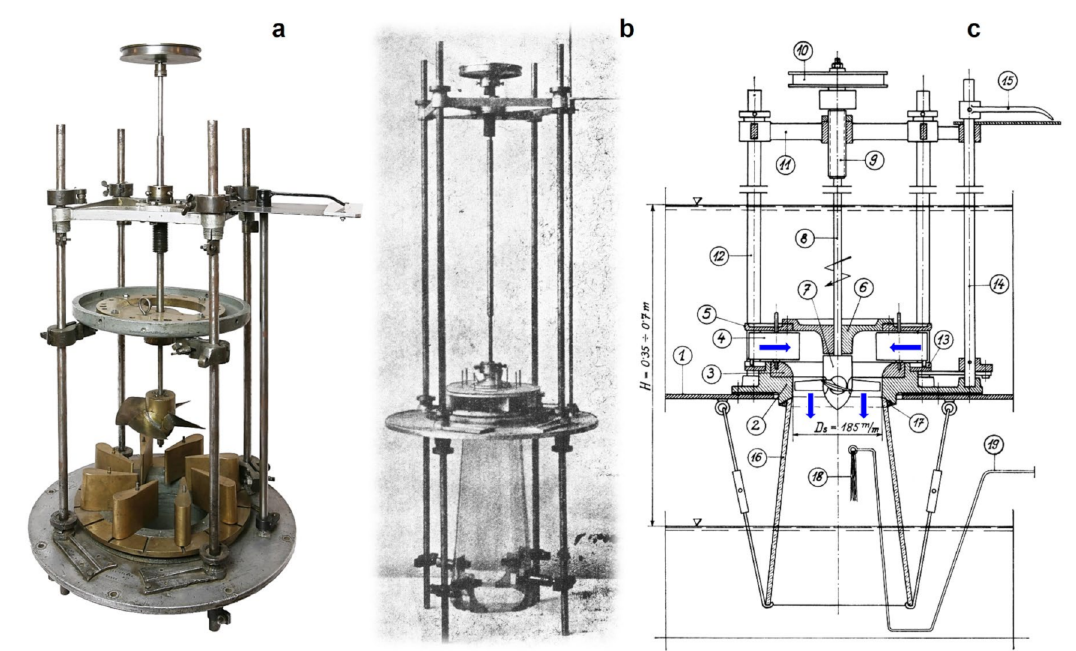
Figure 5. Experimental Kaplan turbine. ( a ) Current photo; ( b ) Historic photo from 1917; ( c ) Turbine scheme. 1: pit bottom; 2: base ring; 3: replaceable insert; 4: replaceable guide blades; 5: guide wheel cover; 6: two-part bearing cover; 7: impeller; 8: shaft; 9: threaded bush; 10: brake disc; 11: adjustable support frame; 12: support columns; 13: control ring; 14: guide blades regulation shaft; 15: regulation arm; 16: replaceable draft tube; 17: hemp seal; 18: hemp fibres; 19: guide wire. Sources: ( a ) [7]; ( b ) [6]; ( c )